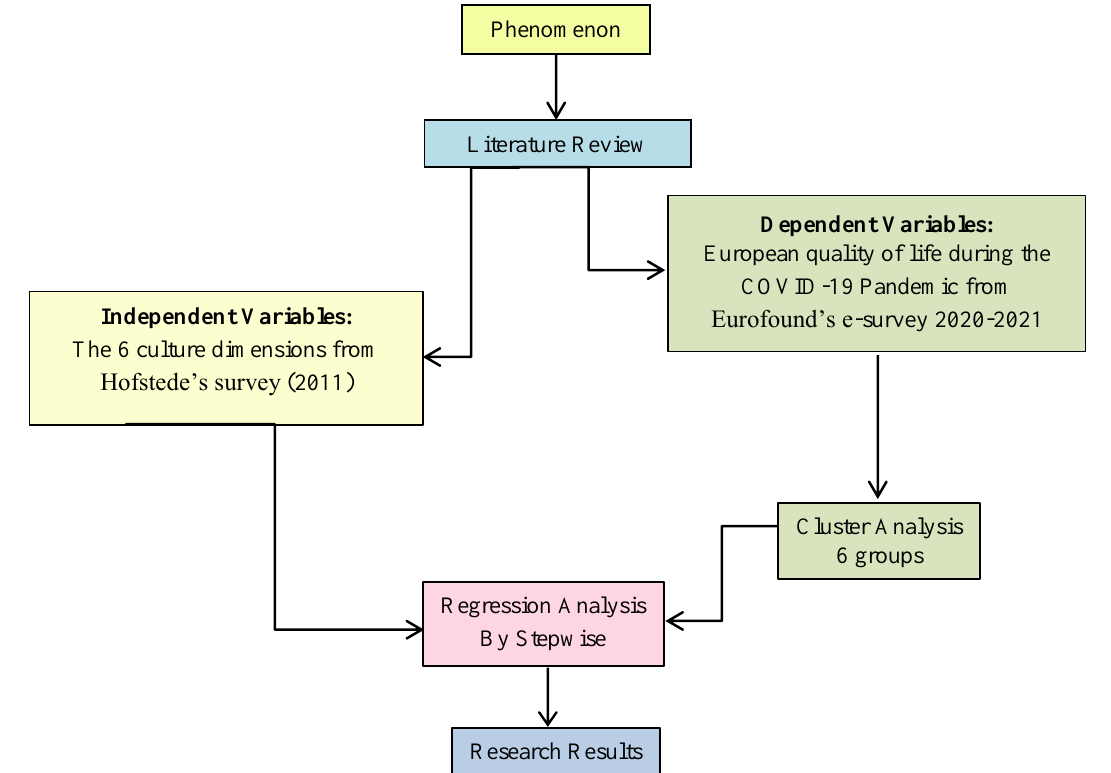
Figure 1. Flowchart of finding the relationship between independent variables and dependent